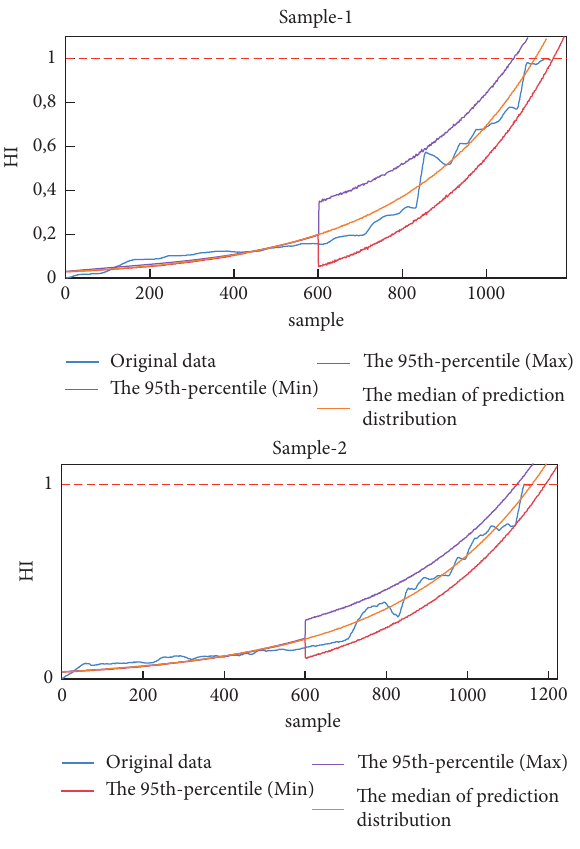
Figure 9: Results of several predictions.